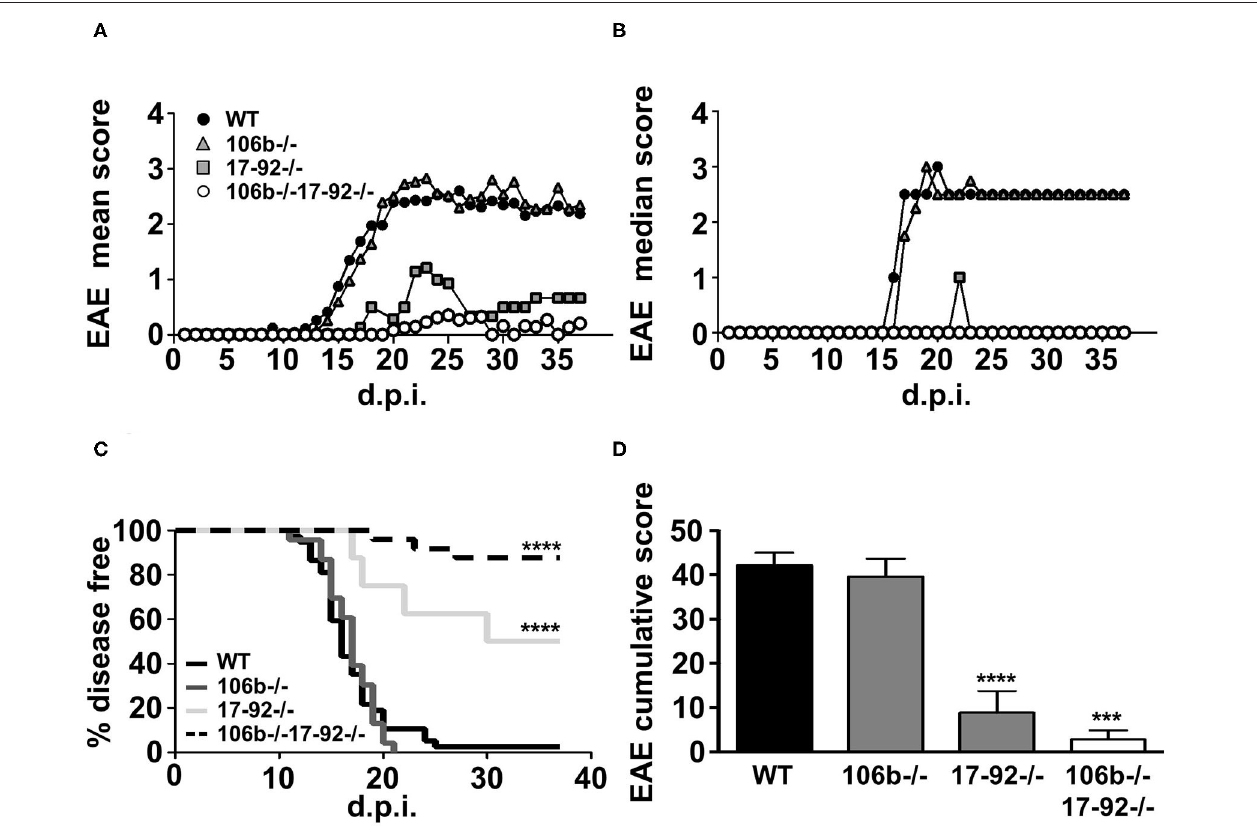
FIGURE 2 | Mice lacking miR17-92 or both miR17-92 and miR106b are protected from clinical signs of EAE. WT ( n = 41), 106b − / − ( n = 29), 17-92 − / − ( n = 8), and 106b − / − 17-92 − / − ( n = 25) mice were immunized to induce EAE. Clinical signs of EAE were monitored daily until day 37 post-immunization. Mean (A) and median (B) clinical score and disease incidence (C) were assessed for each group. The Log-Rank (Mantel Cox test) was used for the comparison of EAE incidence rates between the different groups. EAE was evaluated as cumulative score using Mann Whitney test (D) . Error bars indicate mean ± SEM. *** P ≤ 0.001 and **** P ≤ 0.0001.